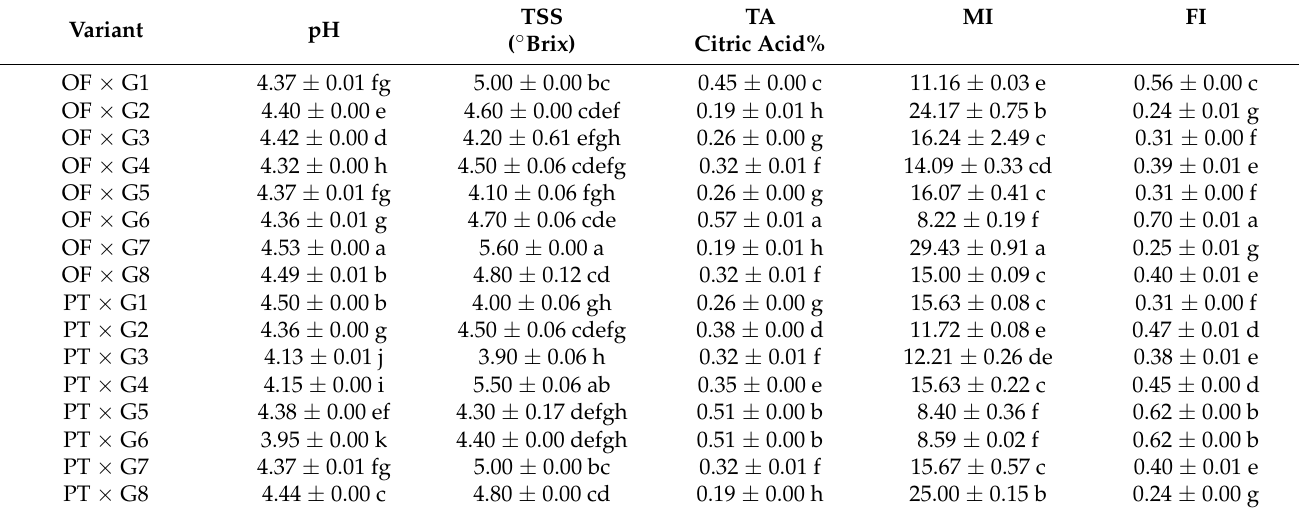
Table 3. The influence of crop system × genotype on the physicochemical